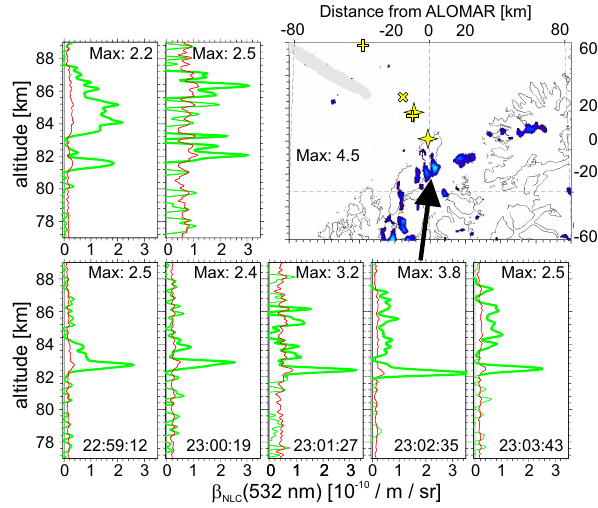
Fig. 12. Temporal evolution of the NLC observed by ALOMAR RMR-lidar from 22:59 to 23:04UT. The upper row shows the NWT observations towards the North-West. The lower row shows measurements by the SET above ALOMAR. Tropospheric clouds blocked the NWT beam after 23:00. In the upper row we also show a map of the faint NLC as observed by the camera at 23:02:37UT. Stars in the map mark the lidar sounding volumes, pluses mark the ECOMA measurements on up and downleg and x-symbols mark the MASS measurements